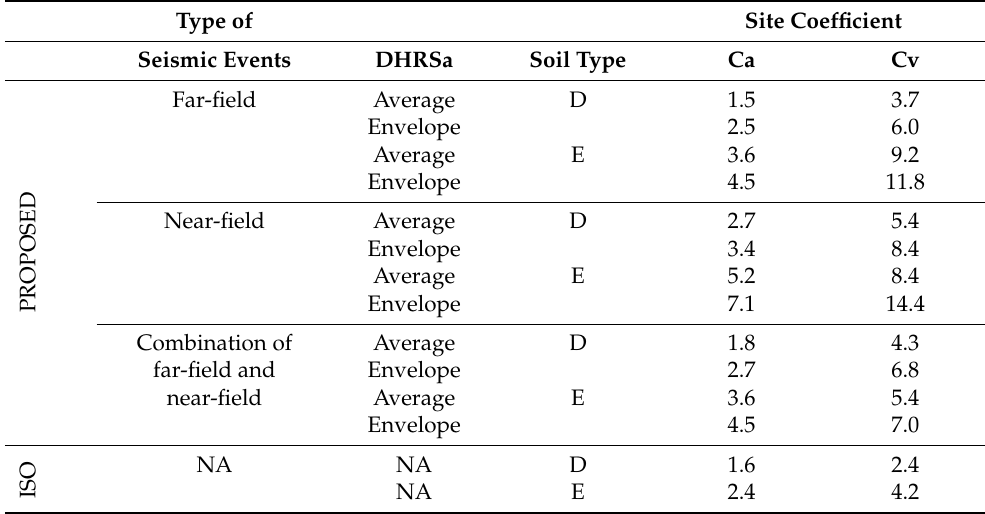
Table 5. Comparison of the proposed Ca and Cv values with ISO19901-2. Type of Site